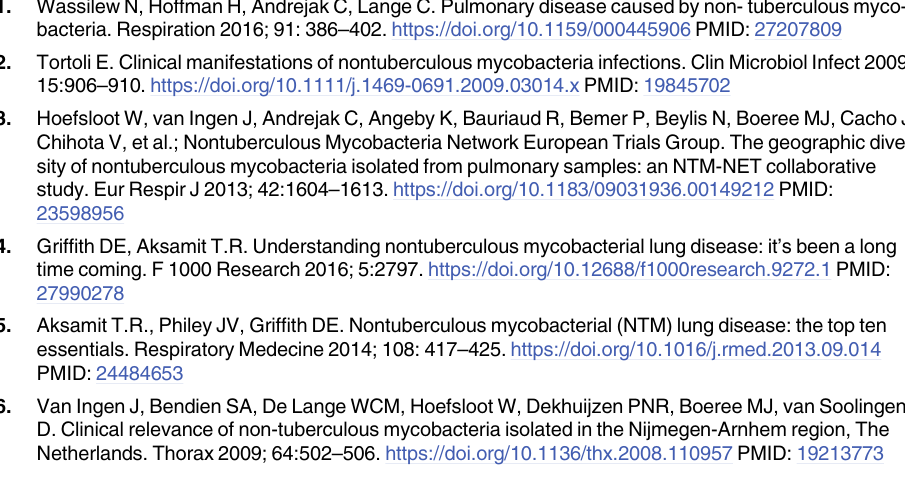
S2 Table. The general characteristics and treatment outcome of patients infected with Mycobacterium avium complex (MAC). S3 Table. The general characteristics and treatment outcome of patients with positive HIV-serology. S4 Table. General characteristics and treatment outcomes analyzed by gender (Male/ Female). S5 Table. STROBE